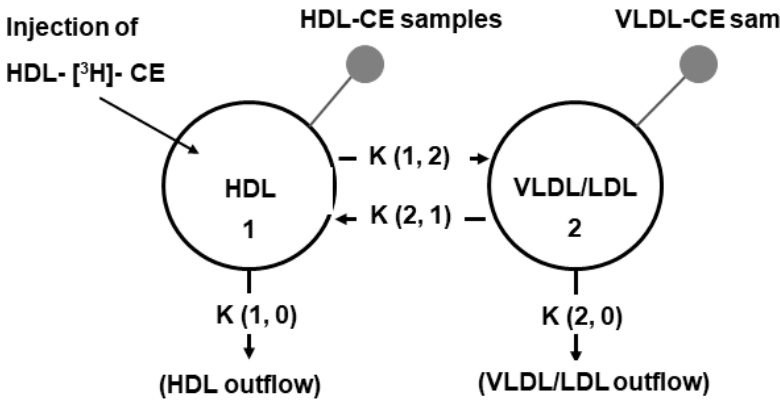
Figure 3. Compartmental model for the transfer of CE between lipoproteins. Circles represent the two lipoproteins compartments and the arrows represent the direction of the transfer or the elimination pathway of cholesteryl esters. Full circles represent the compartment where the samples were obtained.